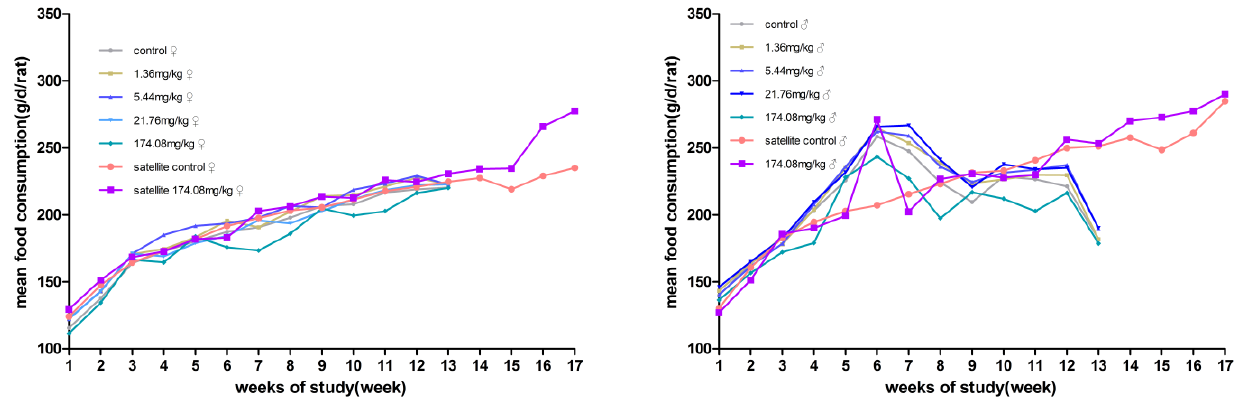
Figure 2. Average body weight of rats orally administered with AQ for 90 days. ( Left ) female; ( Right ) male.